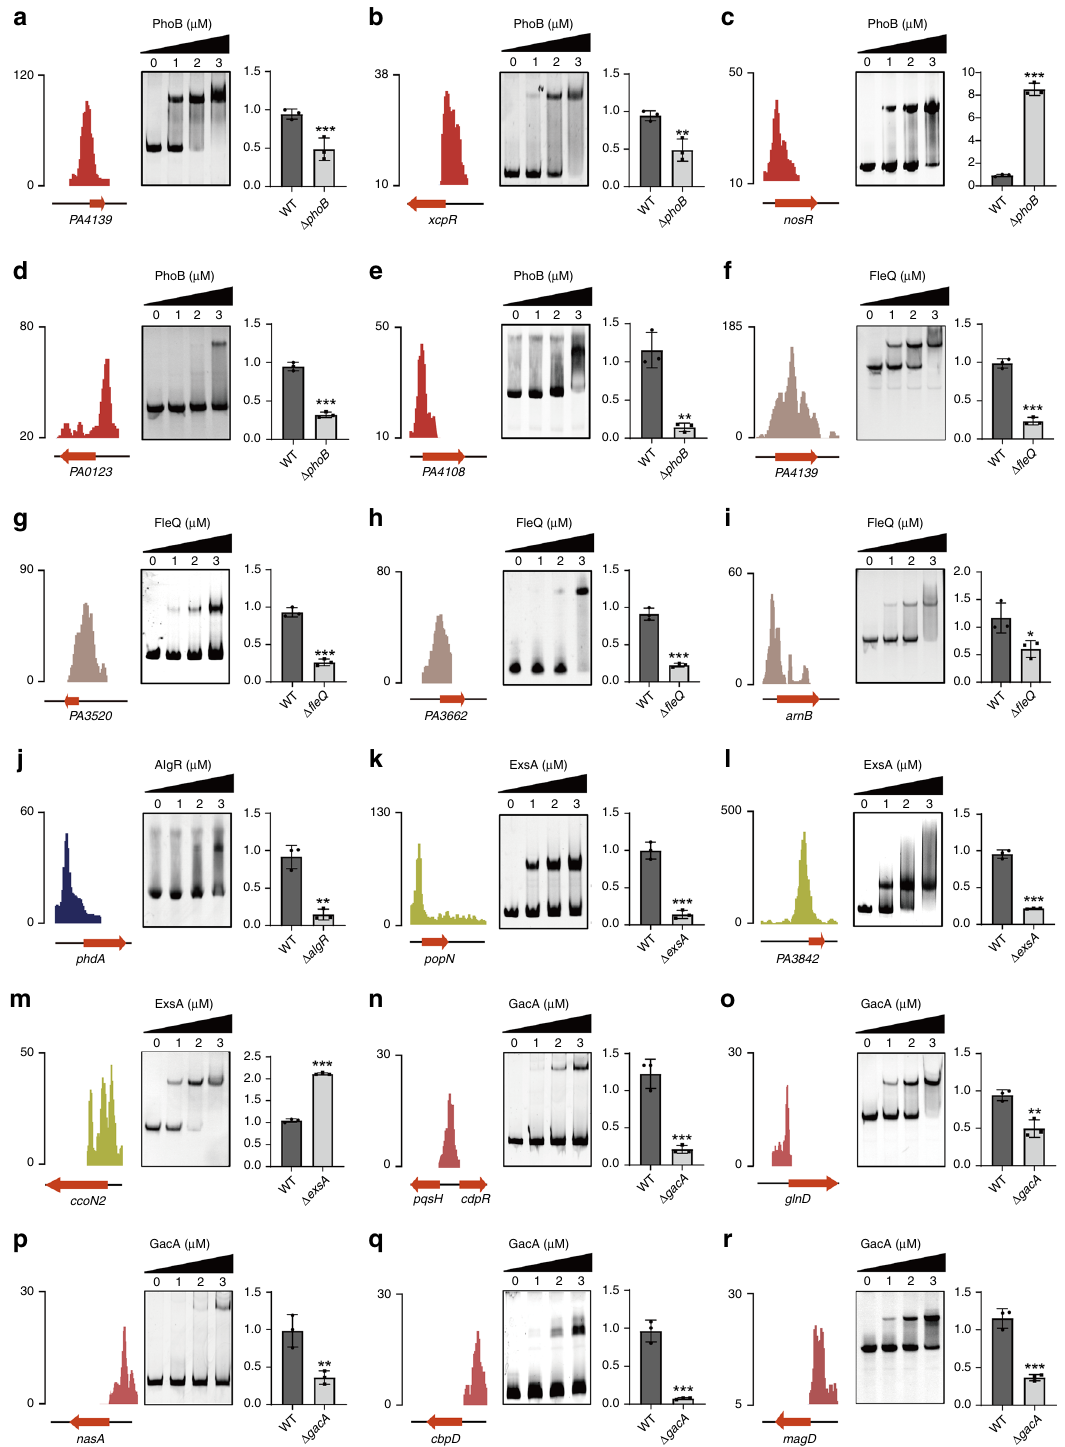
Fig. 6 Veri fi cation of the functional targets of TFs by EMSA and qRT-PCR. The original sequence peaks show the TFs binding regions, and TFs binding regions (PCR-ampli fi ed from P. aeruginosa PAO1 genome) identi fi ed by ChIP-seq were mixed with an increasing amount of puri fi ed TFs protein for the EMSA assay. The expression of target genes was examined by RT-qPCR at the same time. PhoB directly regulated the transcription of PA4139 ( a ), xcpR ( b ), nosR ( c ), PA0123 ( d ) and PA4108 ( e ). FleQ directly regulated the expression of PA4139 ( f ), PA3520 ( g ), PA3662 ( h ) and arnB ( i ). AlgR directly regulated expression of phdA ( j ). ExsA directly regulated the expression of popN ( k ), PA3842 ( l ) and ccoN2 ( m ). GacA directly regulated the expression of cdpR ( n ), glnD ( o ), nasA ( p ), cbpD ( q ) and magD ( r ). All experiments were repeated at least three times. Two-tailed Student ’ s t -tests were used to examine the mean differences between the data groups. * P < 0.05, ** P < 0.01 and *** P < 0.001. Error bars show standard deviations